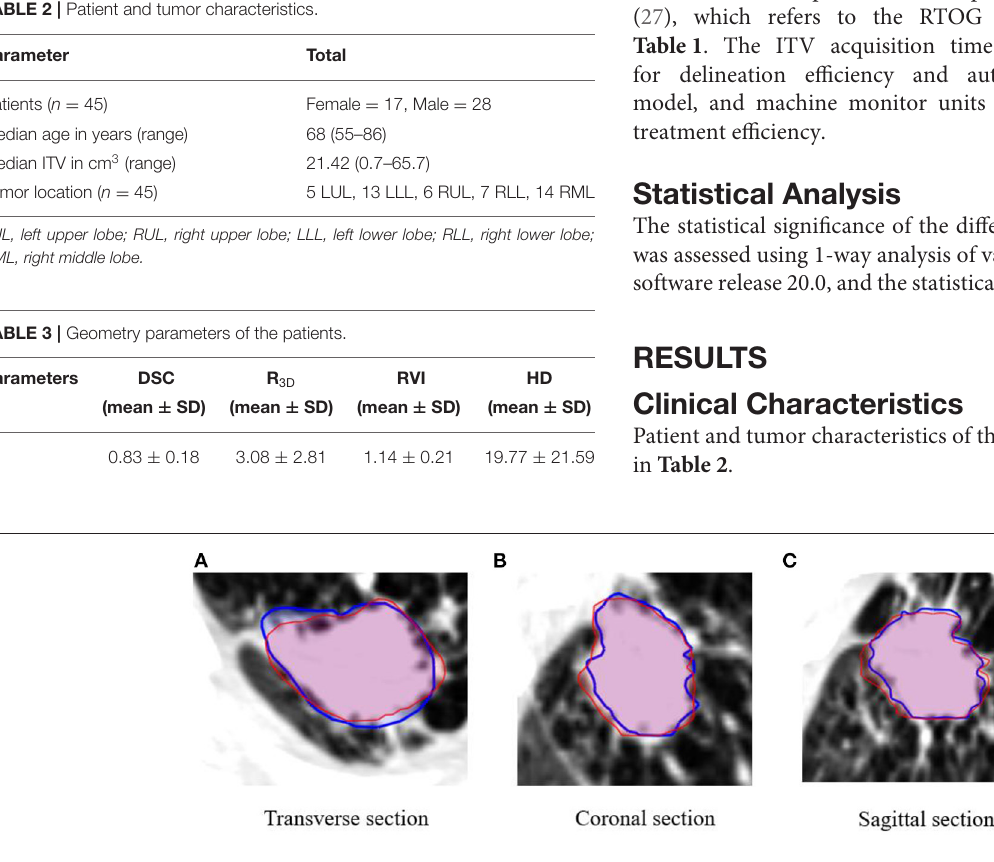
FIGURE 3 | Comparison of contours between ITV on the 4-dimensional CT (ITV 4DCT , red) and ITV prediction (ITV predict , blue) in different views of patient images.